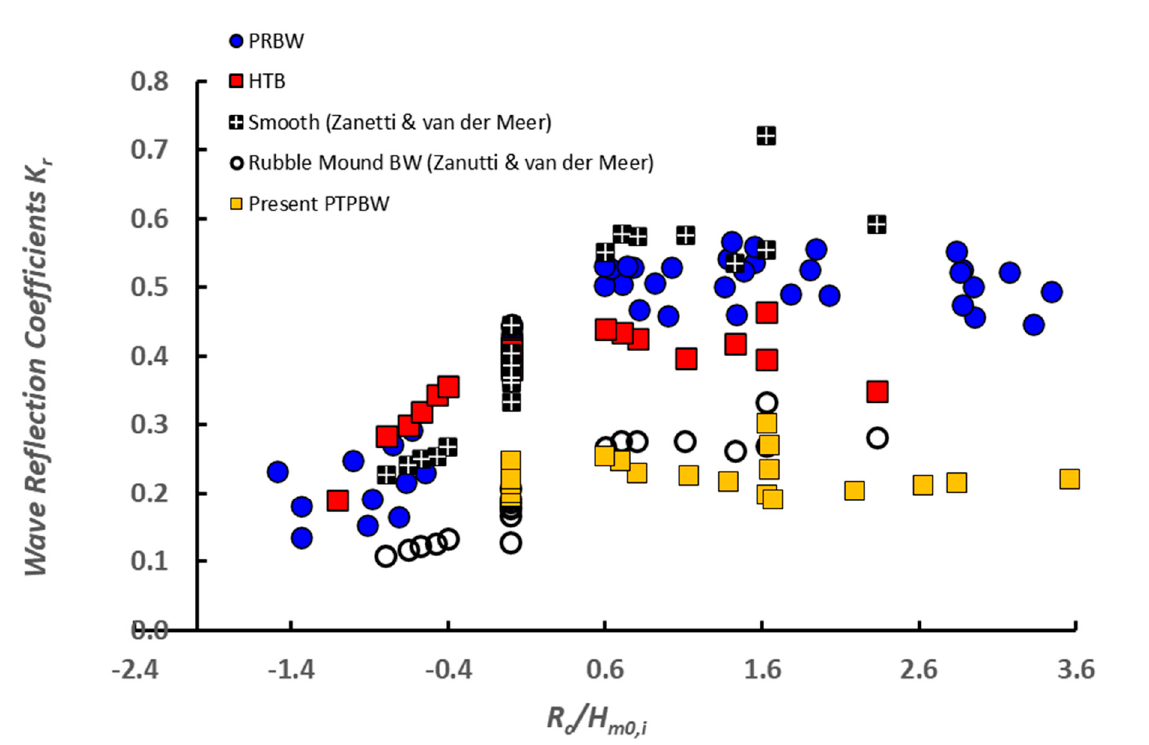
Figure 16. Wave reflection coefficients versus relative crest freeboards of different breakwaters: PRBW (Le Xuan Tu et al., 2020) [10], HTB (Le Xuan Tu et al., 2022) [11], smooth breakwater (Zanutti and van der Meer, 2008) [4], and rubble-mound BW (Zanutti and van der Meer, 2008) [4].